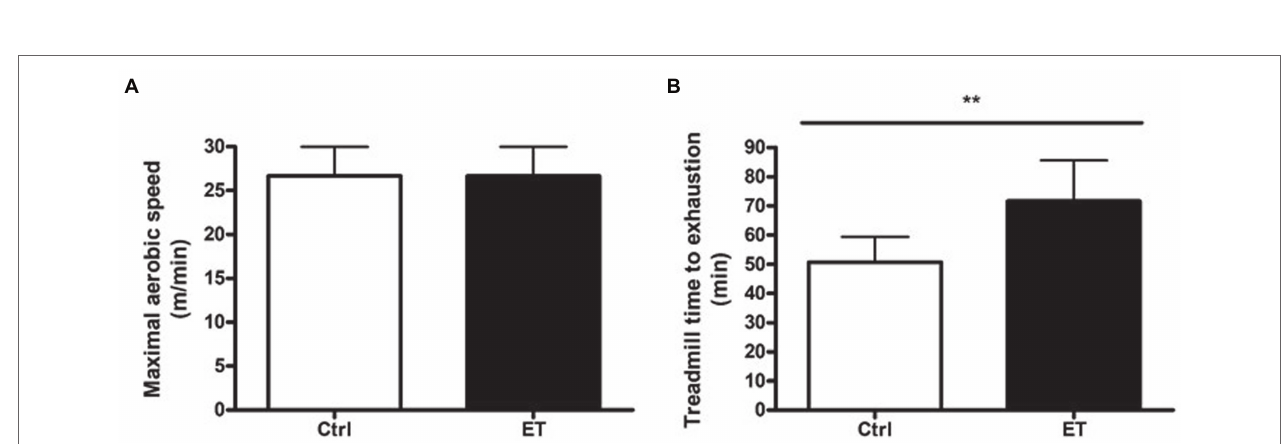
FIGURE 2 | Functional tests. (A) Maximal aerobic speed (treadmill running; m/min) in the ergothioneine (ET; n = 9) and control (Ctrl; n = 9) groups before starting ergothioneine supplementation. (B) Time to exhaustion test (min) by running on a treadmill at 70% of the maximal aerobic speed after 1 week of ergothioneine supplementation (ET) or not (Ctrl). * p < 0.05, ** p < 0.01 vs.